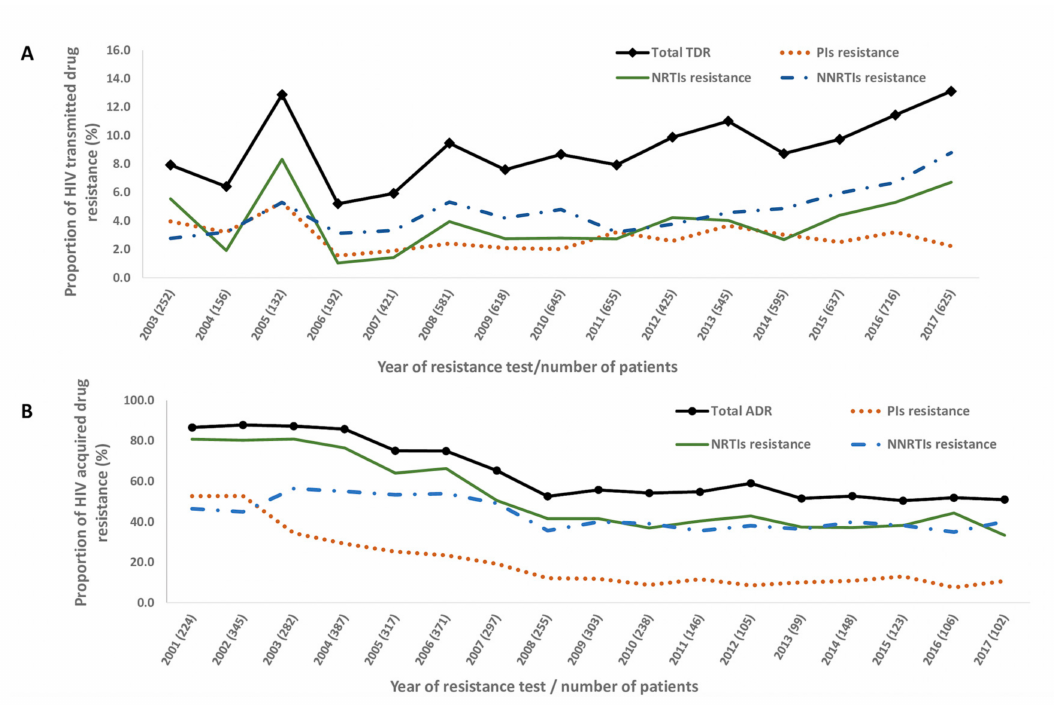
Figure 1. Proportion of ( A ) transmitted drug resistance (TDR) in sequences from ART-NP between 2003 and 2017 and ( B ) of acquired drug resistance (ADR) in ART-EP between 2001 and 2017. NRTI, nucleotide reverse transcriptase inhibitors; NNRTI, non-nucleotide reverse transcriptase inhibitors; PI, protease inhibitors; ART-NP, antiretroviral-naïve patients; ART-EP, antiretroviral-experienced patients. Single-class mutations increased over time, from 4.4% (2003) to 10.0% (2017), as did